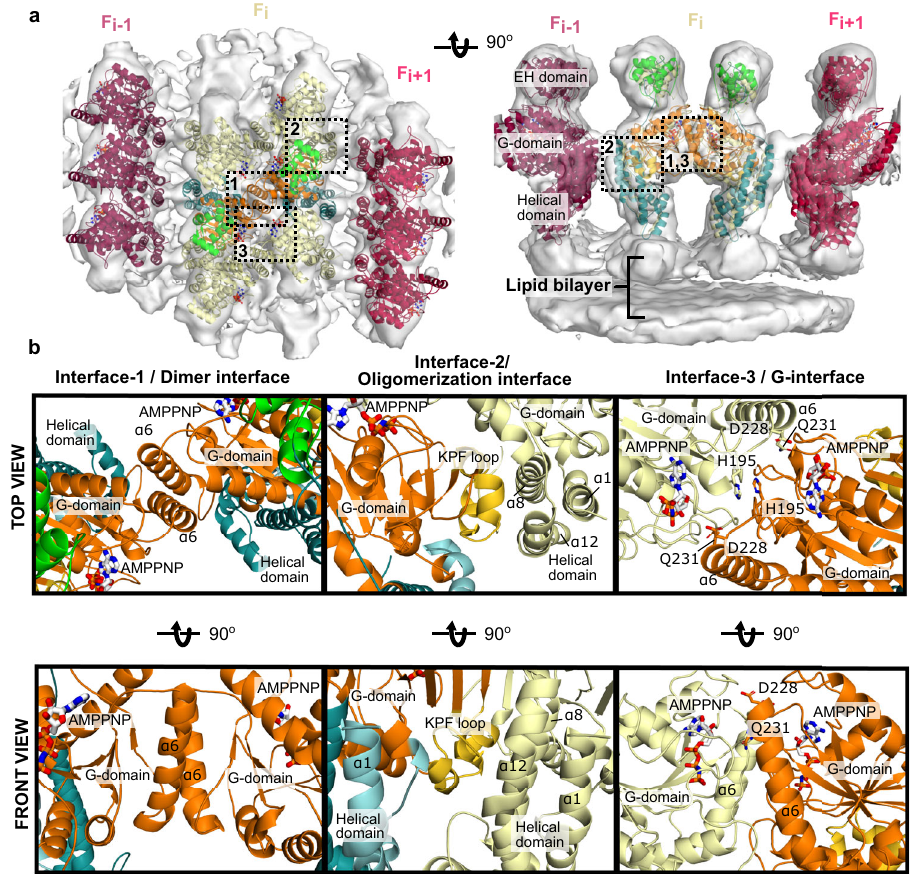
Fig. 2 | Architecture of the EHD4 fi lament. a Asymmetric unit of the cryo-ET reconstruction. In the central EHD4 dimer, the domains are colored according to the domain architecture. The cryo-ET density is indicated as grey surface. b The fi lamentisformedbythreecontactsites.Interface-1comprisesadimerinterfacein